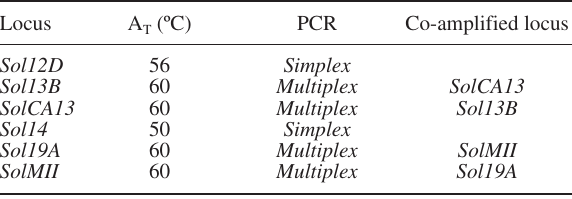
Table 1. – PCR conditions for six polymorphic microsatellite loci used to characterize three samples of Senegalese